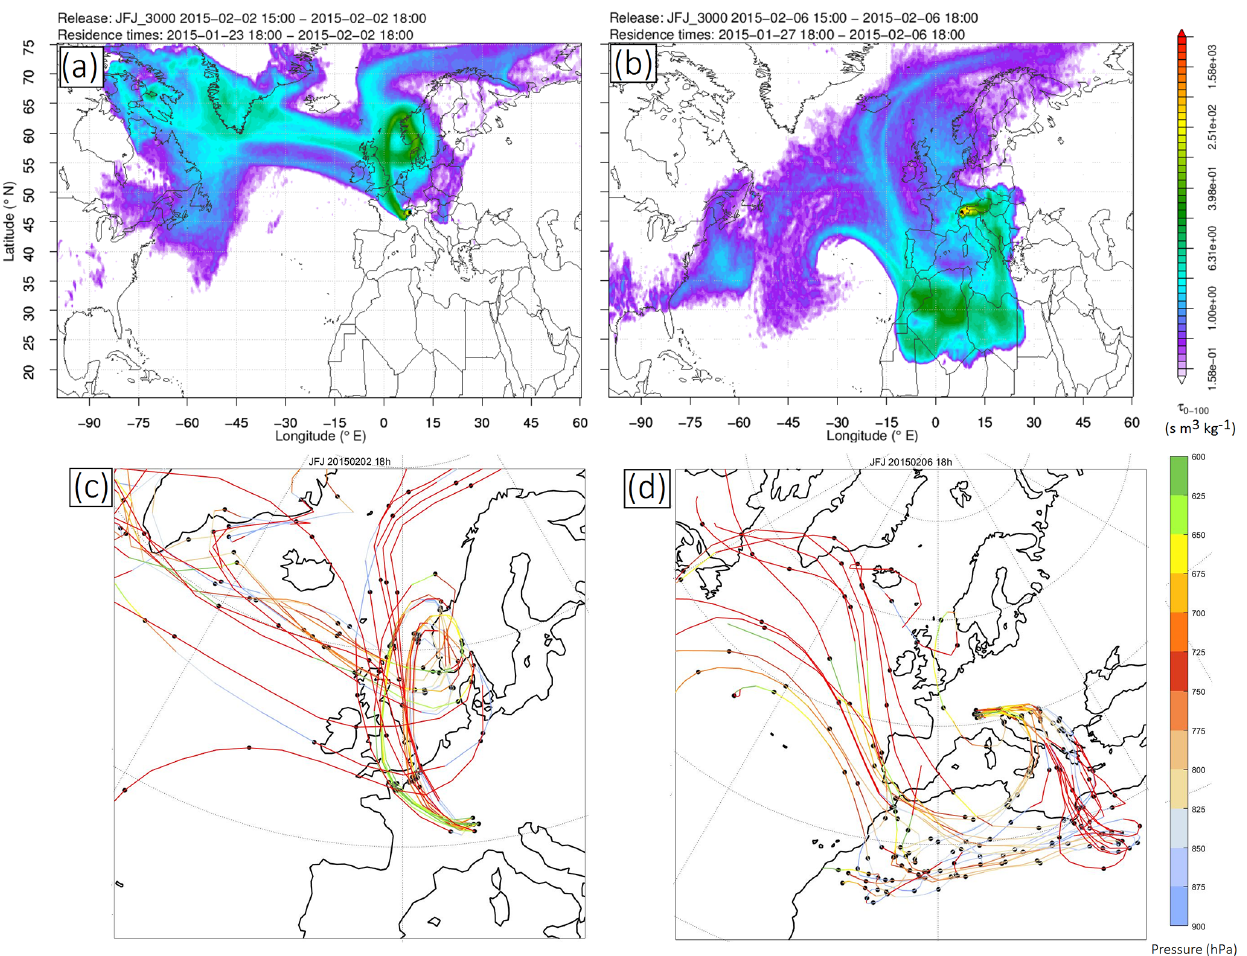
Figure 11. ( a and b ) FLEXPART emission sensitivity fields for 2 (a) and 6 (b) February 2015, calculated 100m above model ground level (http://lagrange.empa.ch/FLEXPART_browser/; Stohl et al., 2005; Sturm et al., 2013; Pandey Deolal et al., 2014); the color code represents the strength of source region contributions to the aerosol burden given in a unit flux per area. ( c and d ) Ten-day back trajectories for 2 (c) and 6 (c) February 2015 calculated with LAGRANTO (Wernli and Davies, 1997); the color code represents the trajectory pressure above model ground, and the black points indicate each 24h back